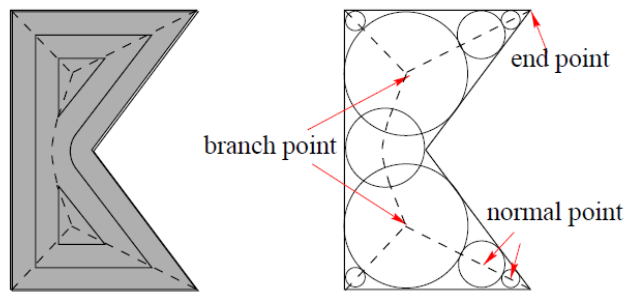
Figure 3. Schematic of different build-up patterns: ( a ) raster, ( b ) zigzag, ( c ) contour and ( d ) spiral. Ding et al. presented in [11]a method for a gap free path pattern generation based on medial axis transformation (MAT). This technique was first proposed by Blum [12].For generating the media axis of a shape, circles with the largest possible radius are inserted in the shape to be filled. As depicted in Figure 4, the centres of all circles build the medial axis, which is basically the line for the parallel filling of the layer.